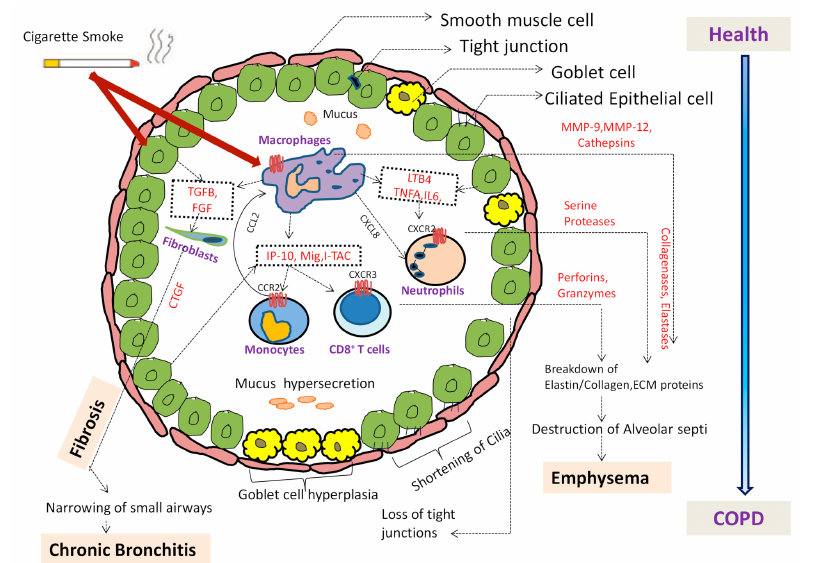
Figure 1. Airway illustration showing the pathological changes in disease condition. Cigarette smoke activates macrophages and epithelial cells in the respiratory tract to release various chemotactic factors. Various cells attracted by these chemokines and cytokines including neutrophils by CXCL8 , monocytes by CCL2 and T cells by CXCL12 . Furthermore, the activation of neutrophils, monocytes, T cells, fibroblasts and airway smooth muscle leads to release of many more cytokines and chemokines. Epithelial cells and macrophages also release fibrogenic mediators like transforming growth factor beta ( TGFB ) and fibroblast growth factor ( FGF ) that activates fibroblasts and release connective tissue growth factor ( CTGF ) resulting in fibrosis of small airways. Proteases, MMPs, cathepsins, collagenases and elastases released by neutrophils and macrophages leads to breakdown of extracellular matrix (ECM) leading to emphysema. Shortening of cilia, loss of tight junctions and goblet cell hyperplasia leading to mucus hyper secretion are other changes occurring in